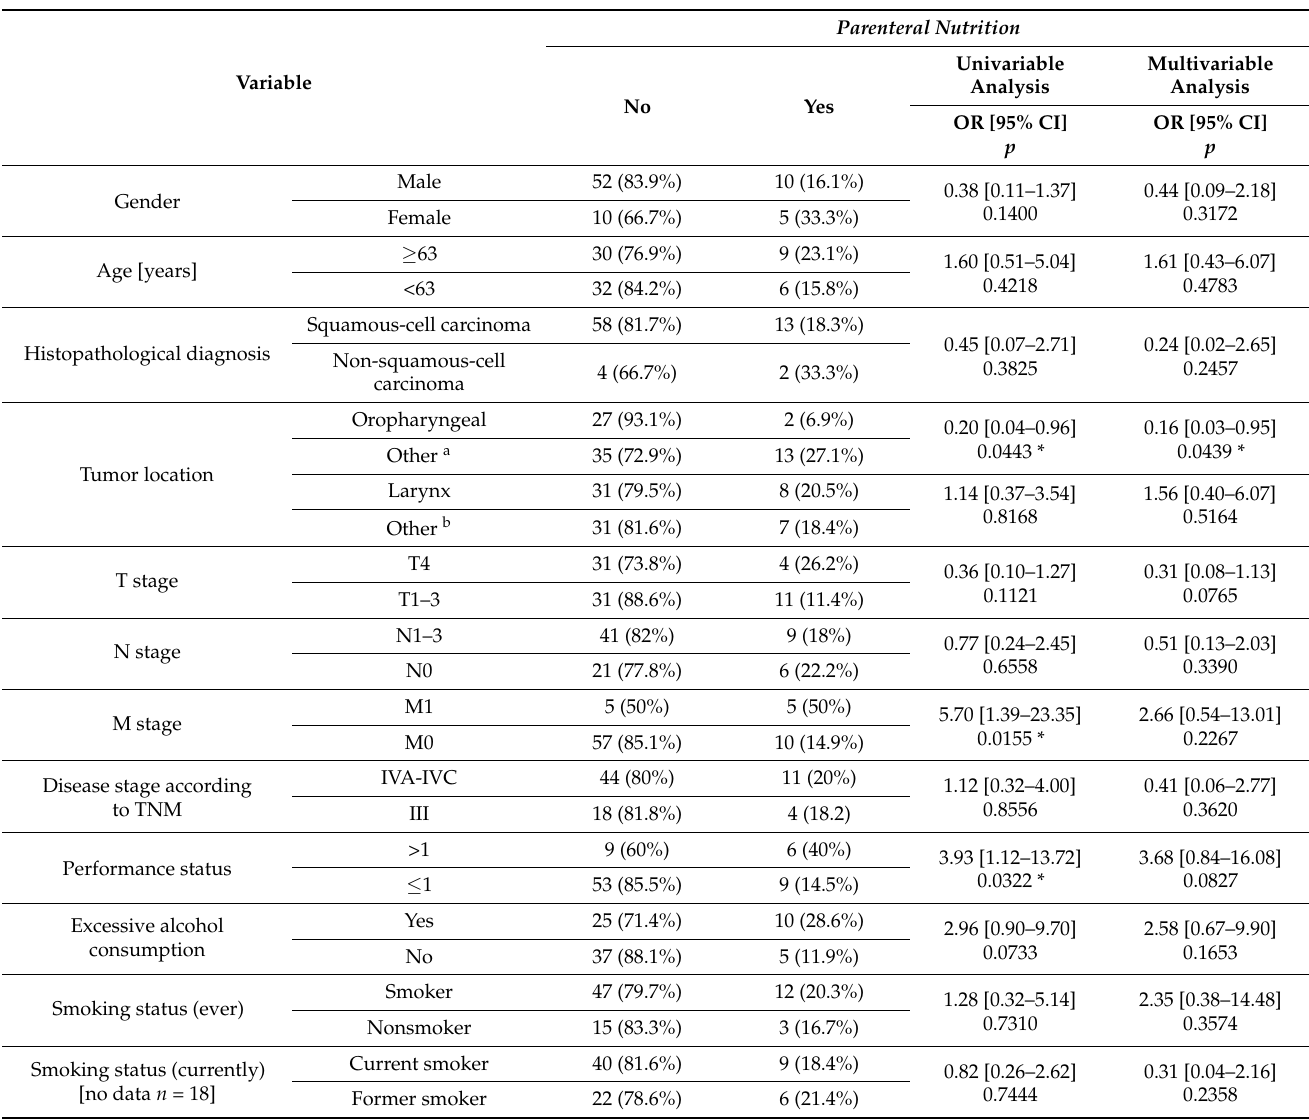
Table 4. The influence of the demographic, clinical, and genetic variables on the parenteral nutrition